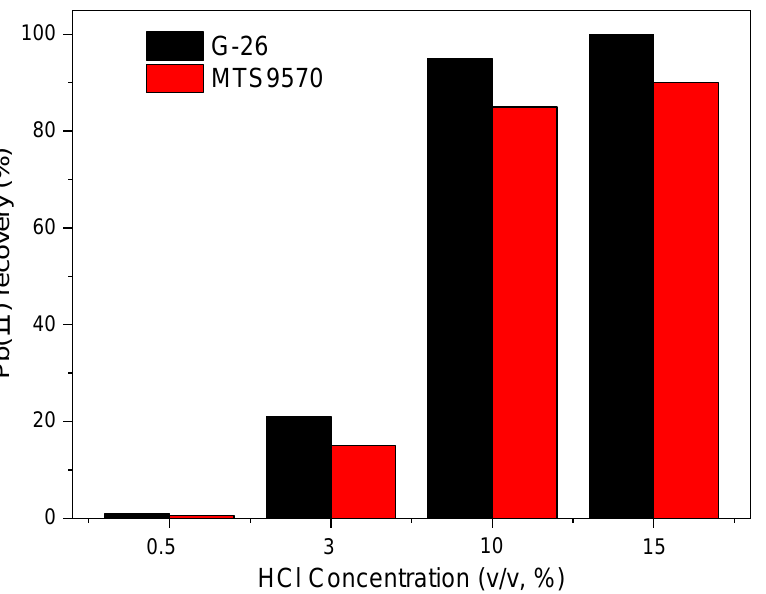
Figure 13. Elution of G-26 and MTS9570 at different HCL concentrations ( v / v ) at 0.5 g of resin dosage, 20 min agitation time, 40 mL volume, and at room temperature. The adsorption-desorption cycle was repeated three times using the same resin, and the results are presented in Table